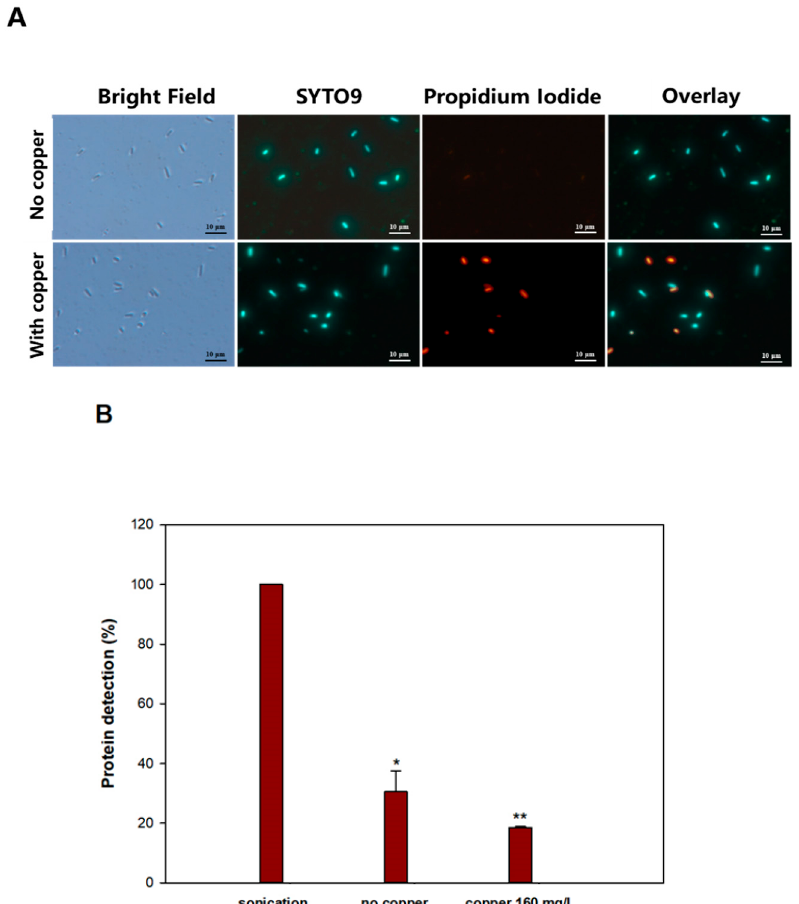
Figure 2. Membrane integrity and cell lysis of persister cells with copper. ( A ) Persister cells were suspended in 0.85% NaCl bu ff er supplemented with cupric sulfate (160 µ g / mL) for 1 h, then treated with Live / Dead staining. Scale bar is 10 µ M. ( B ) Persister cells were treated with copper (160 µ g / mL) or 1 × PBS bu ff er (“no copper”) and protein content was quantified and compared to the positive control of completely-lysed cells via sonication (“sonicated”) * ( p < 0.05); ** ( p < 0.01).